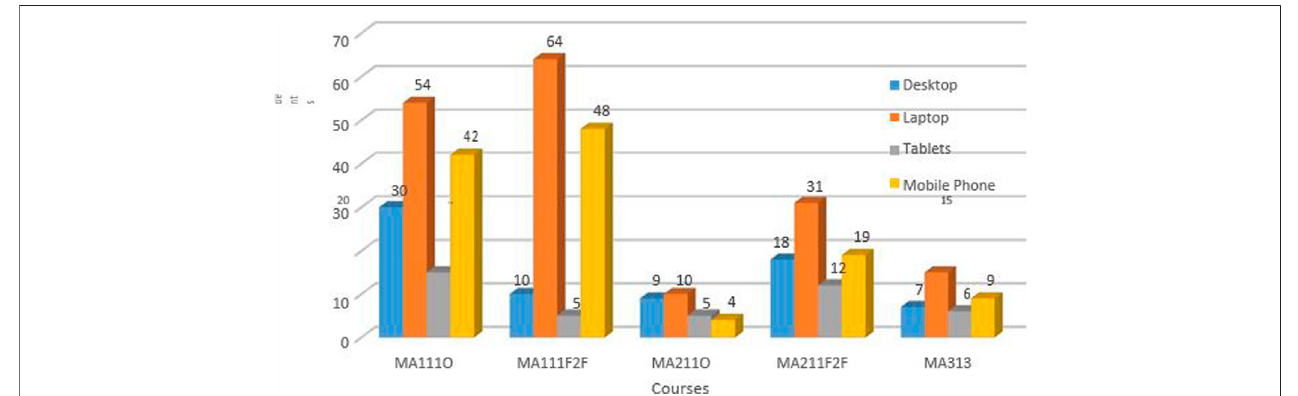
FIGURE 2 | Devices used by the students.